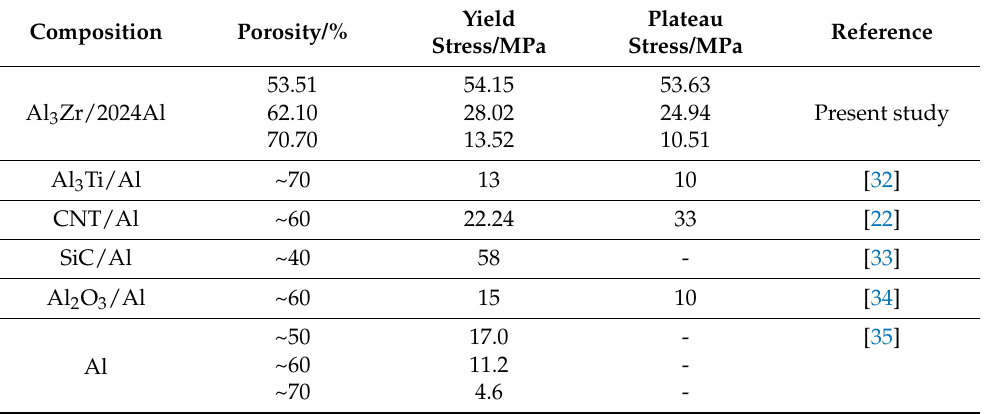
Table 4. Compression properties of different porous